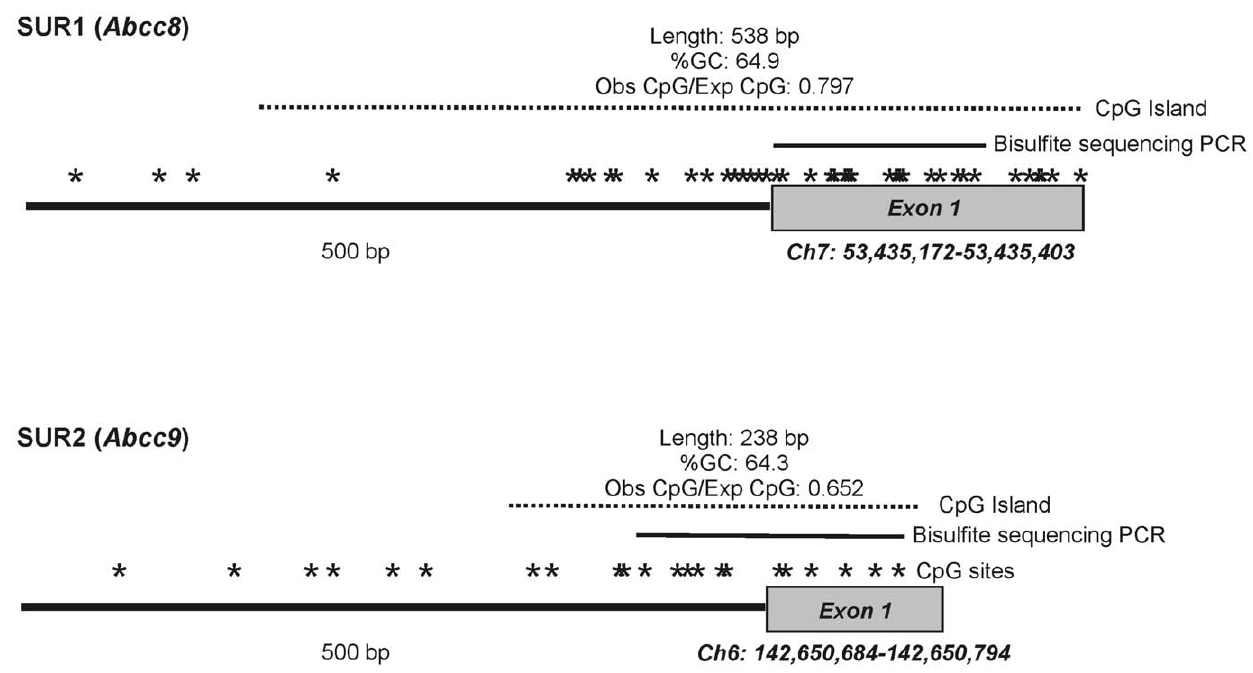
Figure 2. CpG islands in the SUR1 (Abcc8) and SUR2 (Abcc9) genes. Cartoon illustrating the first exon and proximal upstream region of the SUR1 ( top ) and SUR2 ( bottom ) genes are shown. Sequence analysis with CpG Island Searcher software [40], reveals CpG islands in both SUR1 and SUR2 genes, that are at least 200 bp in length, with . 55% GC content and an observed:expected CpG ratio . 0.65. CpG dinucleotides (39 in SUR1 and 16 in SUR2) are marked with an asterisk. The region analyzed in bisulfite sequencing is also marked.